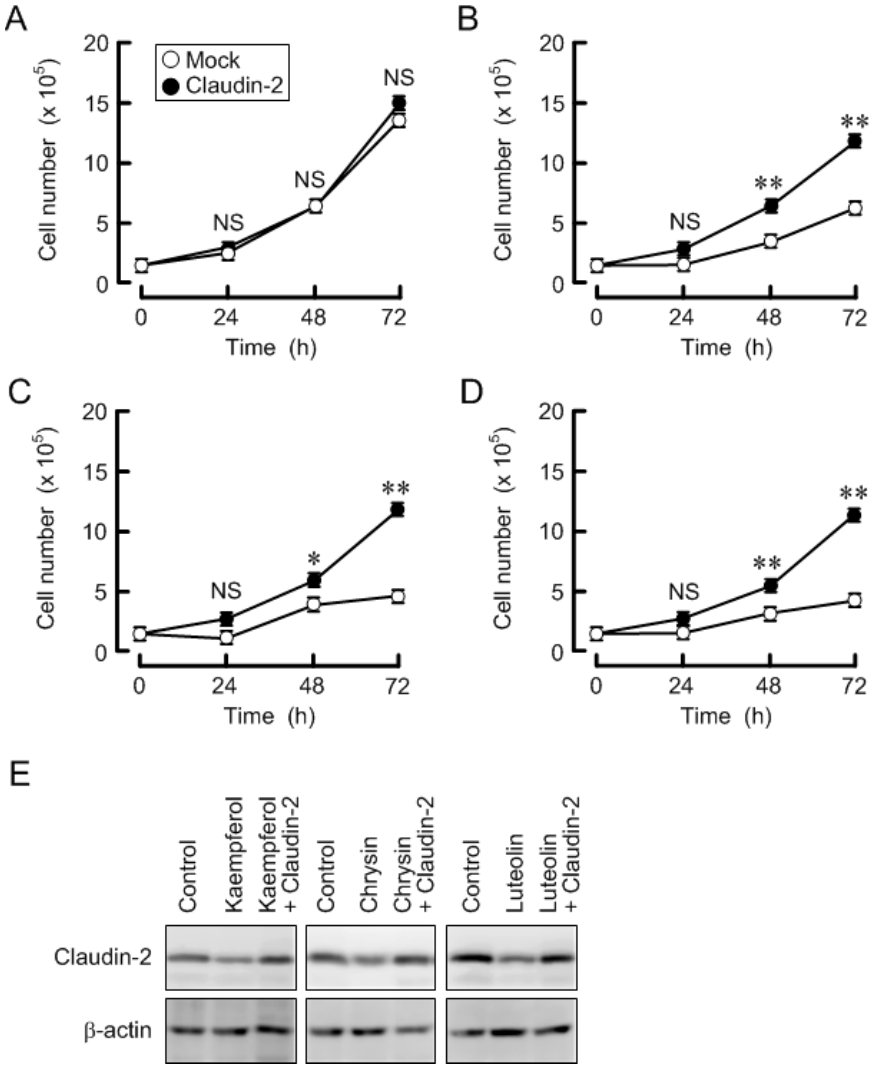
Figure 9. Rescue of cell proliferation by ectopic claudin-2 expression. Mock and claudin-2-overexpressing cells were cultured in the absence ( A ) and presence of 10 μ M kaempferol ( B ); chrysin ( C ); or luteolin ( D ). Cell number was measured at 24, 48, and 72 h after inoculation; ( E ) Cell lysates were immunoblotted with anti-claudin-2 or β -actin antibody. n = 3–4. ** p < 0.01 and * p < 0.05 significantly different from mock. NS, not significantly different.